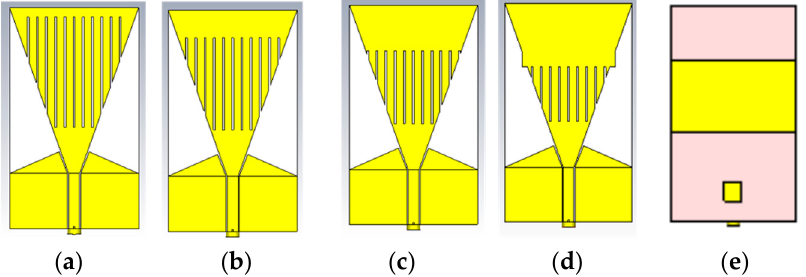
Figure 2. Braided antenna design; ( a ) 5 mm ( b ) 15 mm ( c ) 25 mm ( d ) 35 mm ( e ) back.